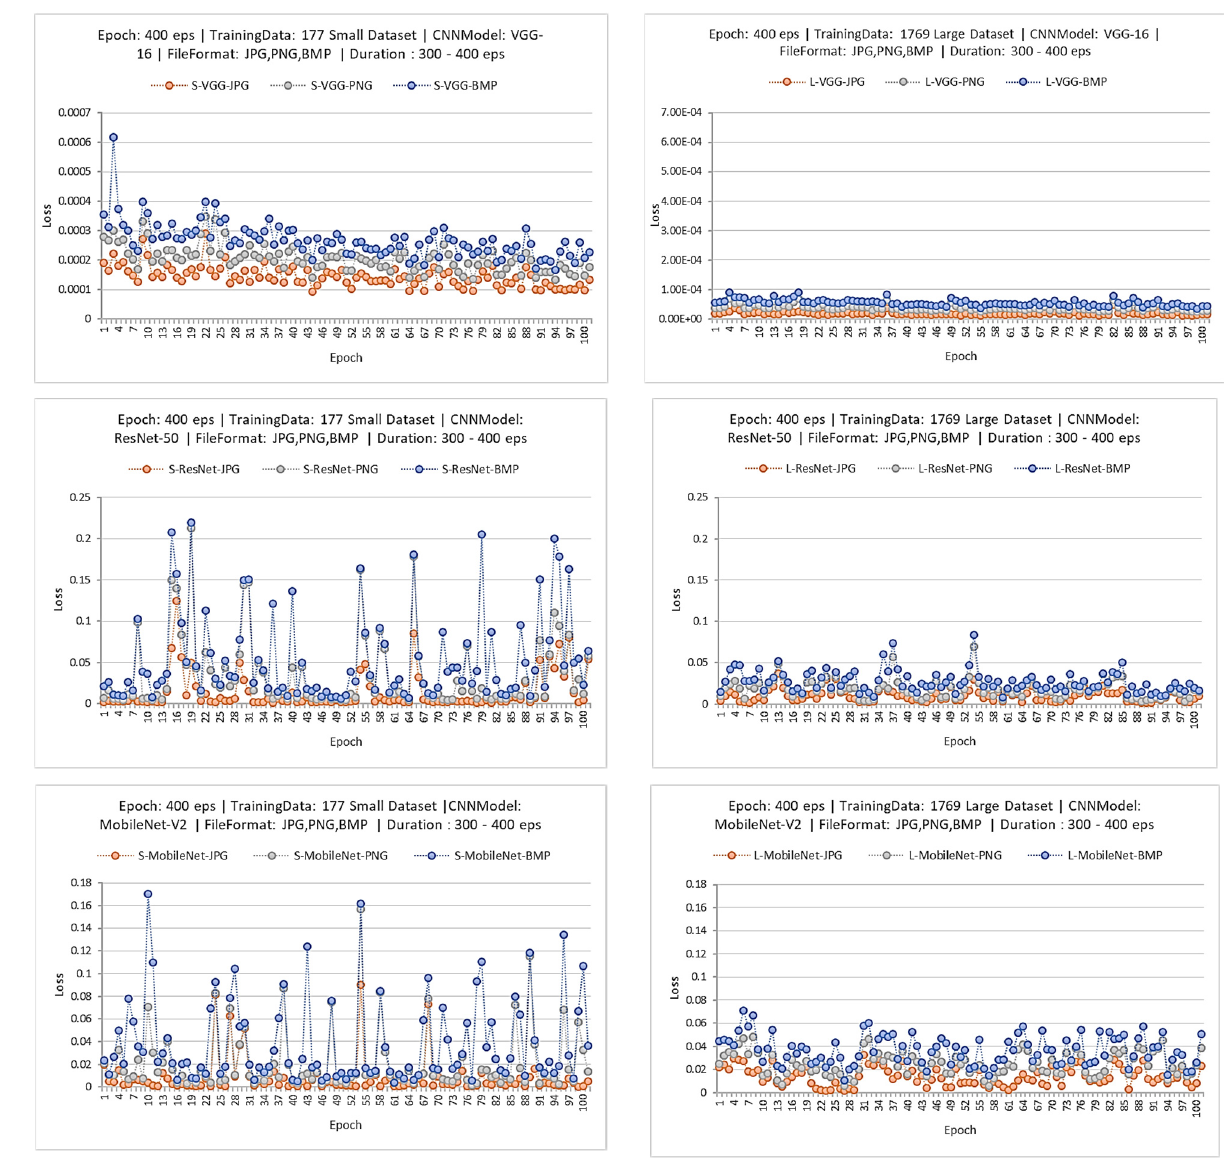
Figure 7. Training graph between 300 to 400 epochs of 18 CNN models trained by the small ( left ) and large ( right ) dataset.